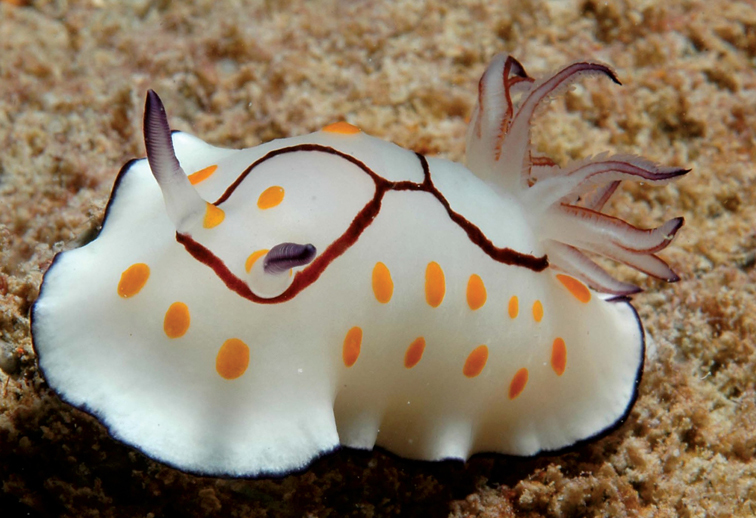
Chromodoris annulata, Persian Gulf, photo: G Smith (no spcm).